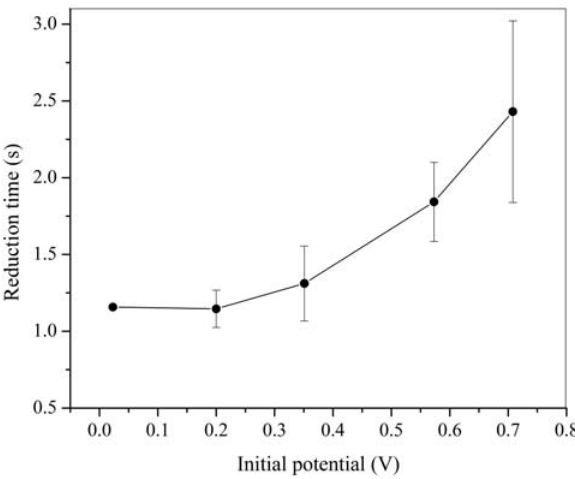
Figure 4. The influence of the initial potential on riboflavin res- ponse (mean ± 2SD, n = 5). (C = 5 mg/L; i = –0.8 Riboflavin